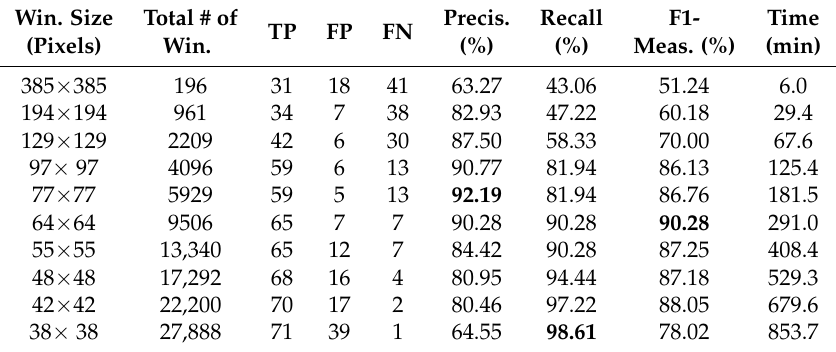
Table 3. CNN-detection results in Test-zone-1 at different sliding window sizes. Accuracies are expressed in terms of true positives (TP), false positives (FP), and false negatives (FN), precision, recall, F1-measure, and execution time of the detection